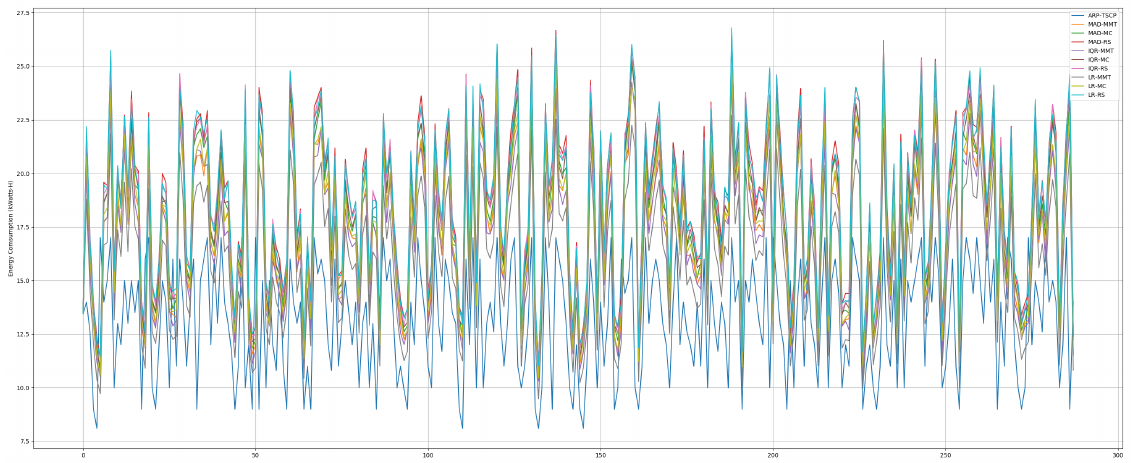
Figure 10. Comparing the energy consumption of hosts by all methods in every time segment.